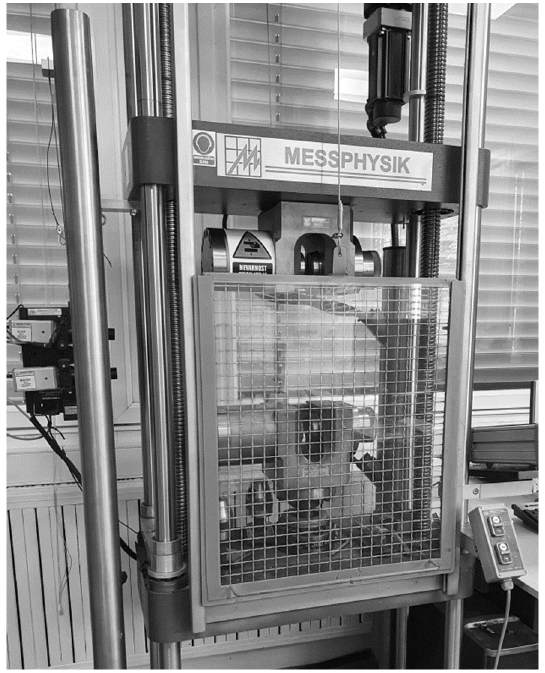
Figure 1. Messphysik Beta 300 tensile test